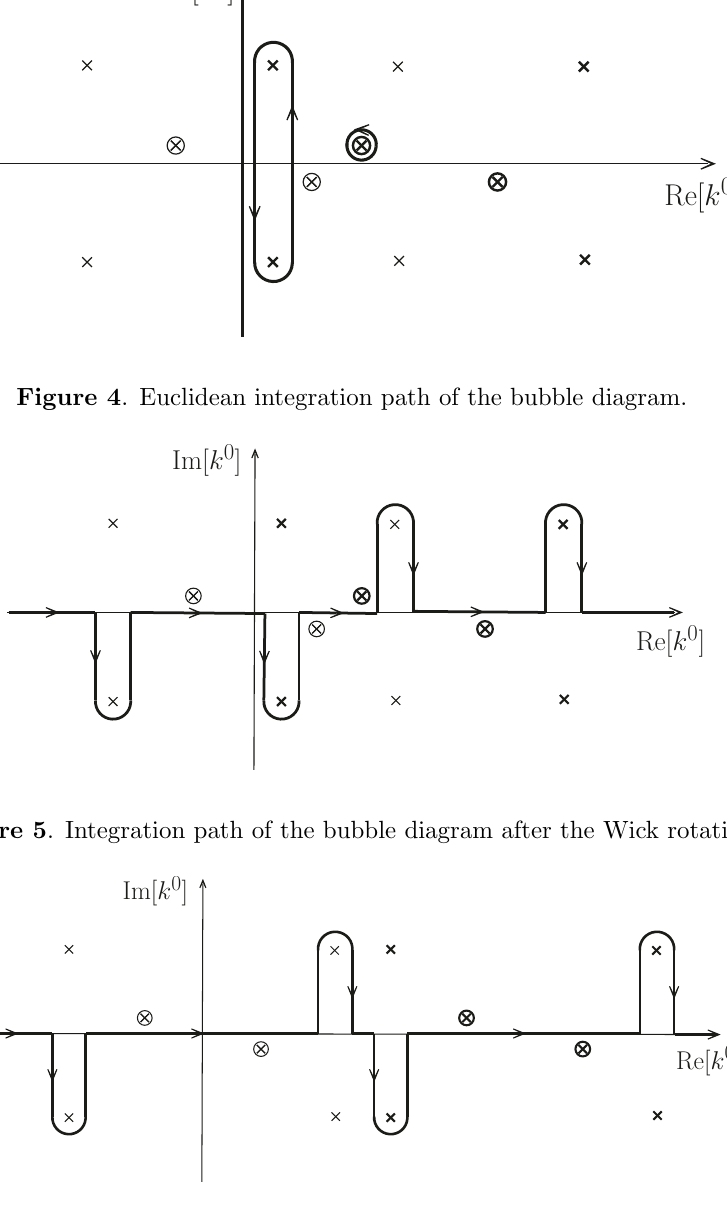
Figure 6 . Integration path of the bubble diagram after the Wick